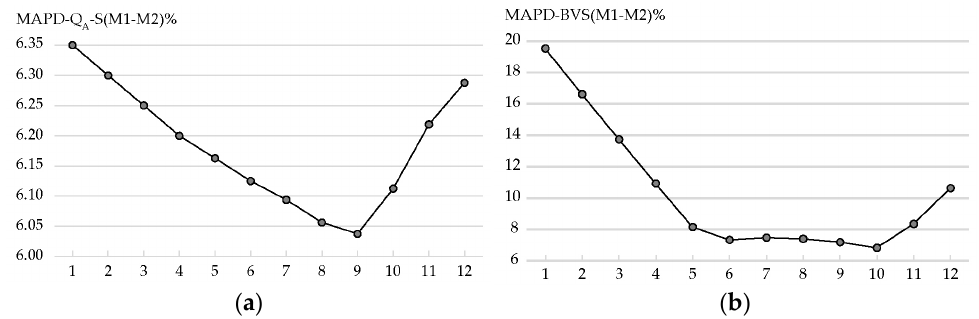
Figure 5. The variation of CD- and BVS- MAPD (%) for various site populations in M1 and M2 sites in the crystal structure of ‘rath7’ (Topa and Kolitsch [34]): ( a ) Q A for ligands of M1 and M2 (S1–S8) in the cation-centered description; ( b ) BVS for M1 and M2 combined (see text and Table 1 for details). The numbers from 1 to 12 represent mixtures with different Pb–Tl ratios (Table 1).